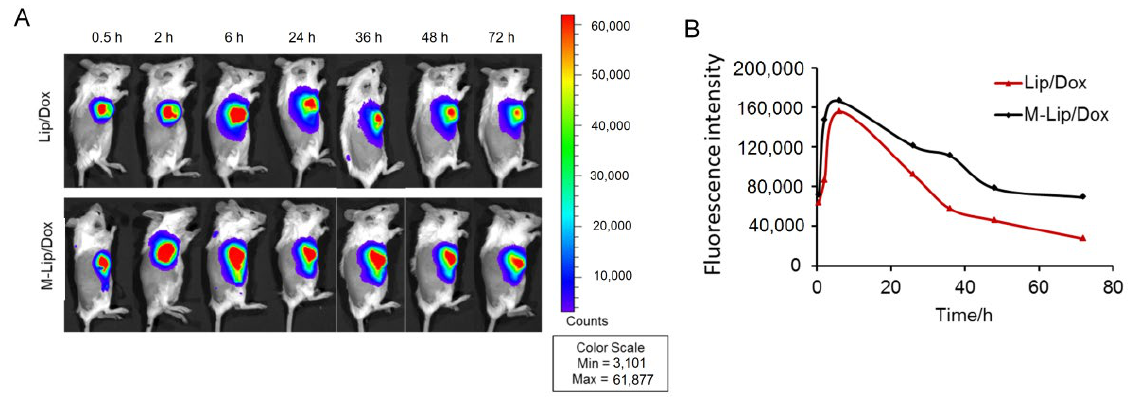
Figure 3. In vivo retention of the liposome after intratumorally injected at the tumor site. ( A ) Near- infrared fluorescence imaging of mice injected with DiD-labeled Lip/Dox and M-Lip/Dox. ( B ) Quan- tification of fluorescence intensity. DiD, 1,1 ′ -dioctadecyl-3,3 ′ ,3,3 ′ -tetramethyl indodicarbocyanine; Dox, doxorubicin; Lip/Dox, Dox-loaded liposomes; M-Lip/Dox, maleimide-functionalized Dox- loaded liposomes.